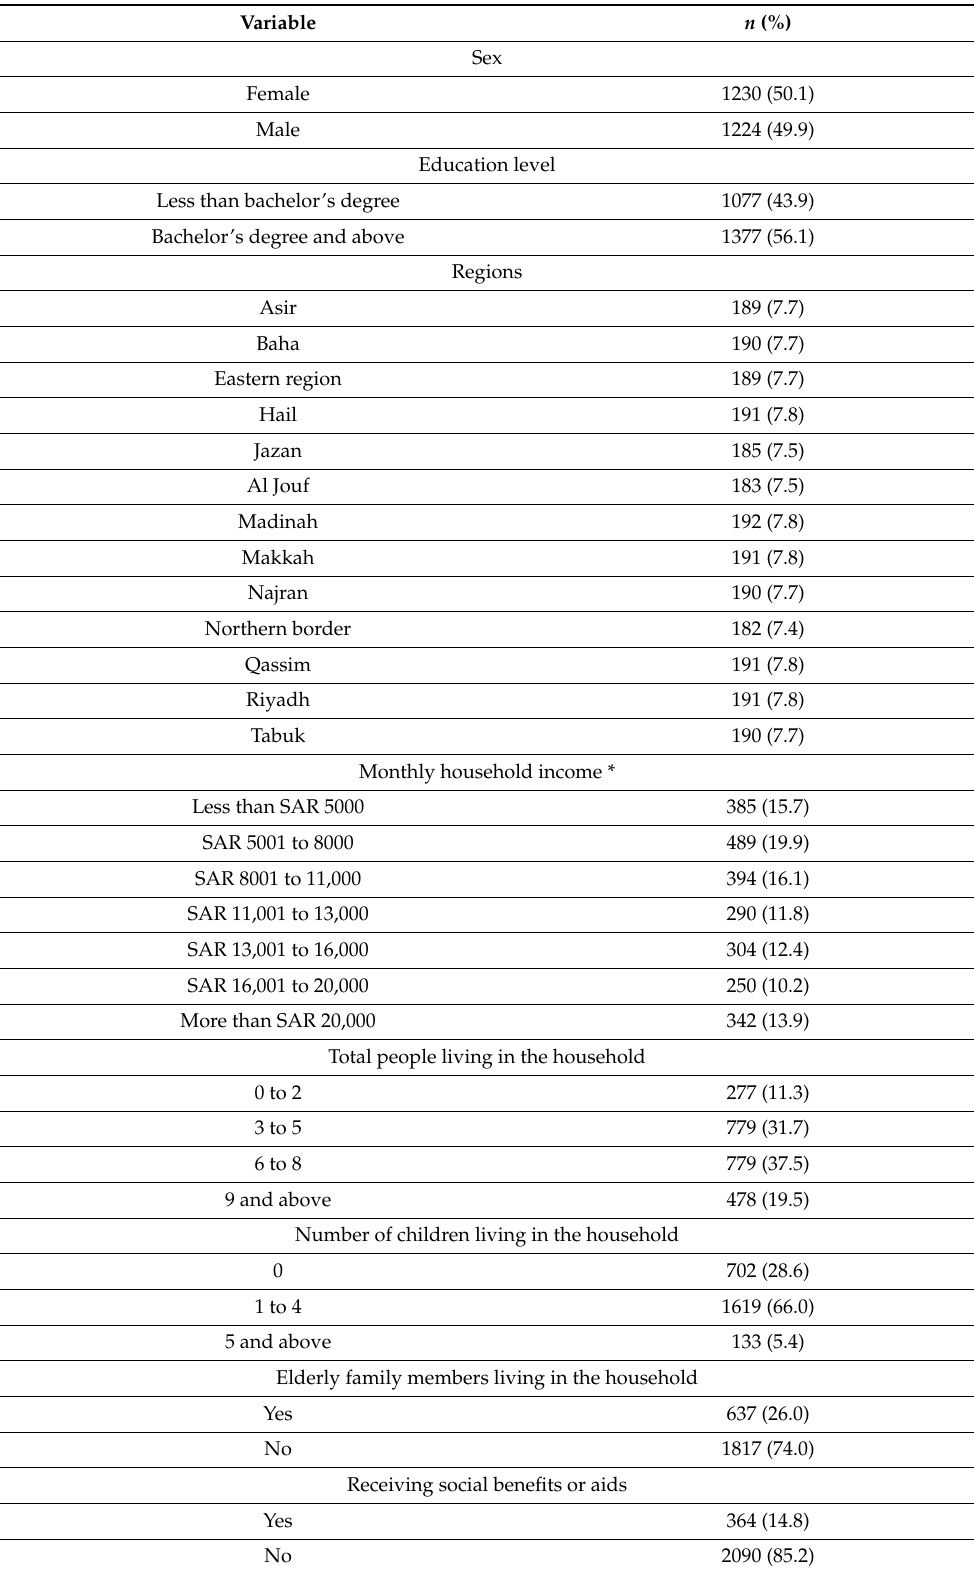
Table 1. Participants’ demographics and household characteristics in the